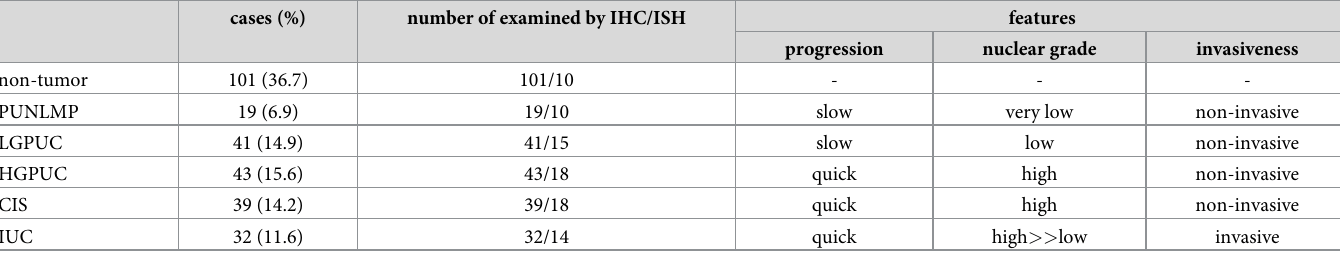
Table 1. Cases for the enrolled 275